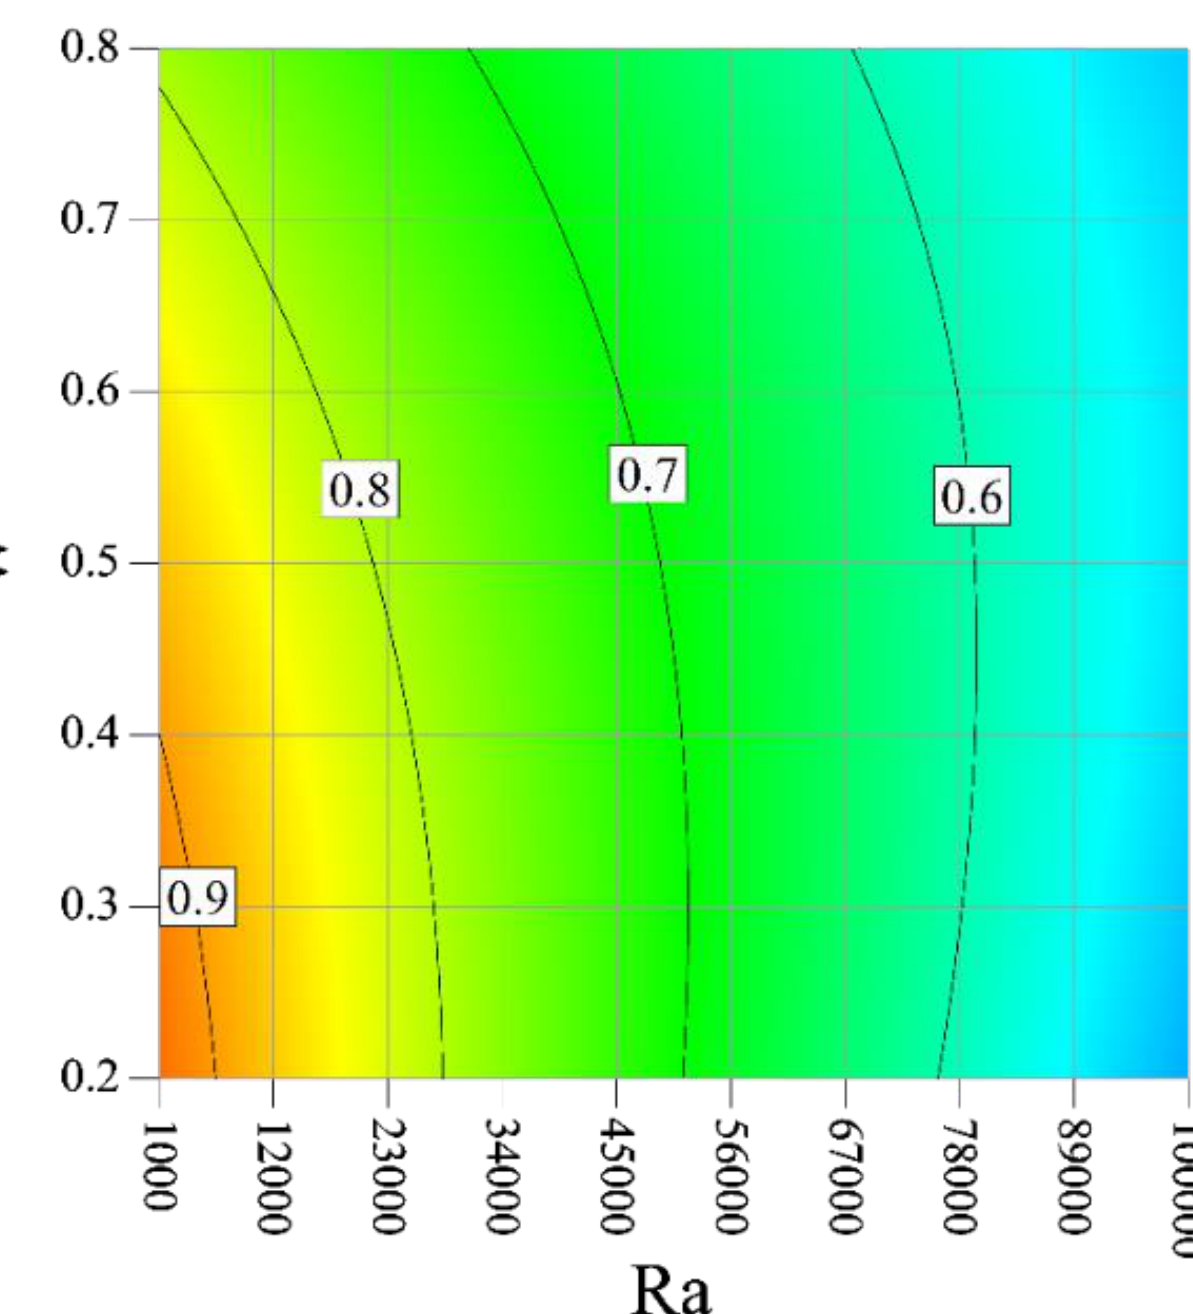
Figure A13. Be for different Ra and various blade heights when H = 0.7 and Ha = 30, and the volume fraction is 0.3%. Figure 14 reveals the EGN for different Ra and various blade heights when H = 0.7